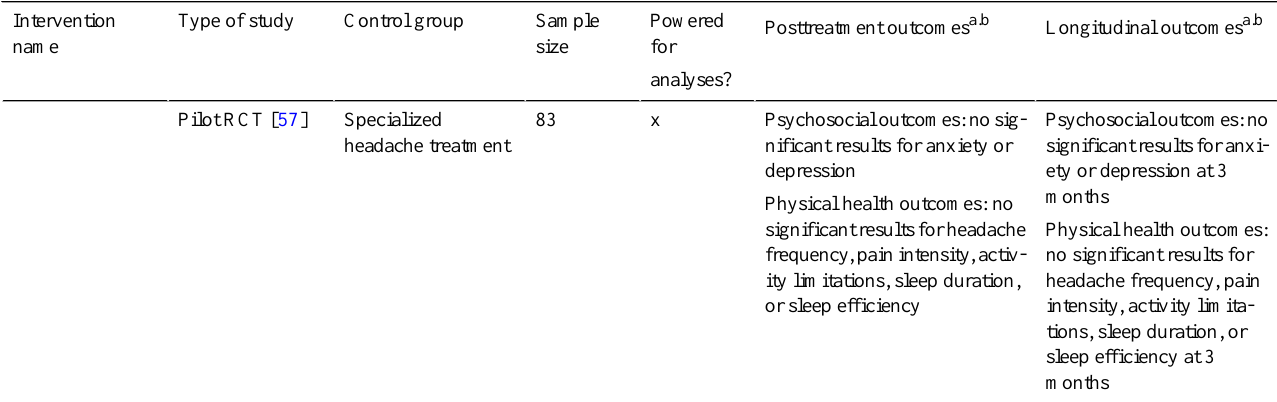
RCT: randomized controlled trial.